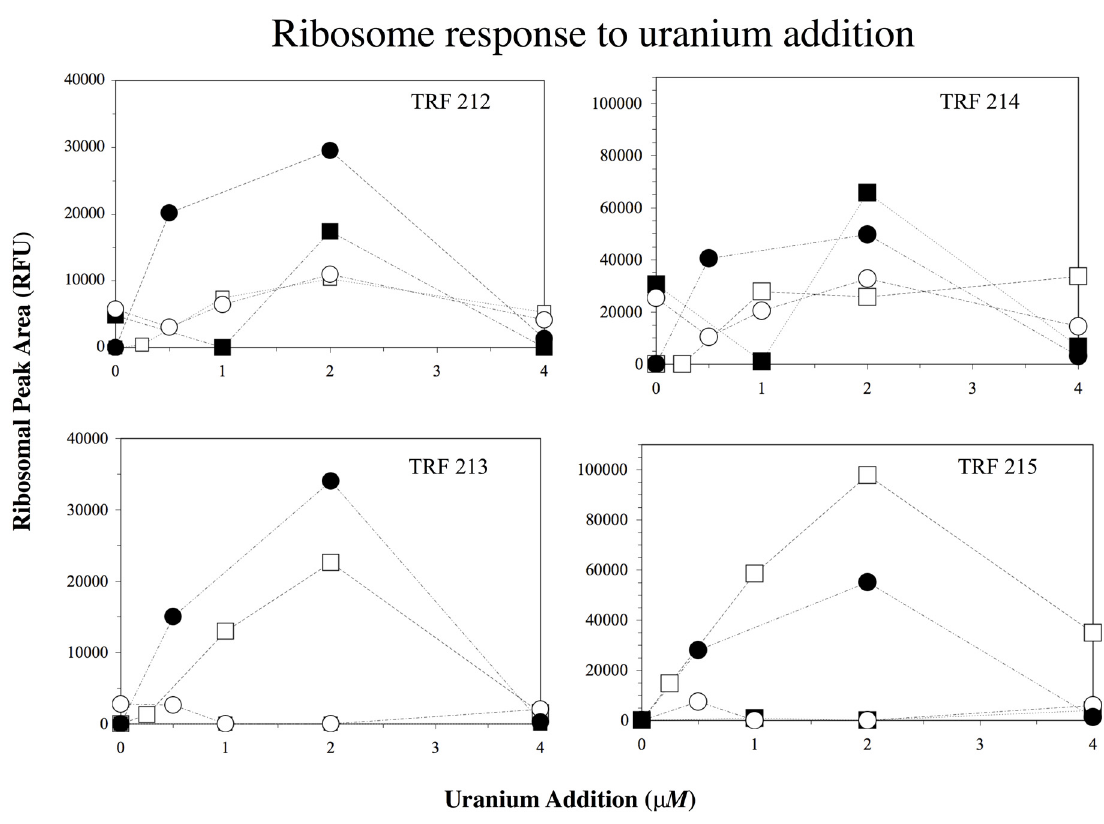
Fig 3. Ribosomal response to uranium additions in groundwater after 24h for 4 OTUs (TRF-212, 213, 214, 215 bp) from wells D02 (open square), D07 (closed square), sampled in 2008, D01 (open circle), D08 (closed circle), sampled in 2009 (note the difference in scales).